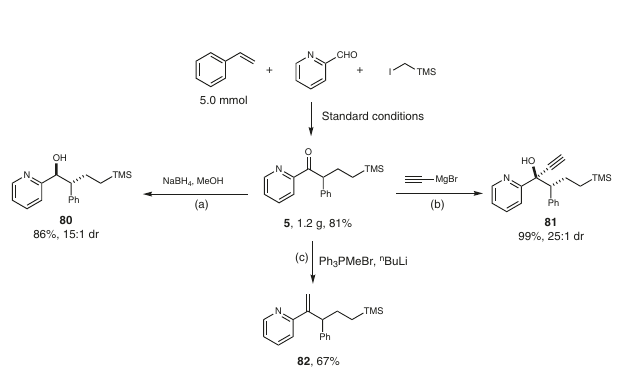
Fig. 5 | Gram-scale synthesis and further chemical transformations. a NaBH 4 , MeOH, 0 o C to rt. b THF, 0 o C to rt. c THF, 0 o C to rt.